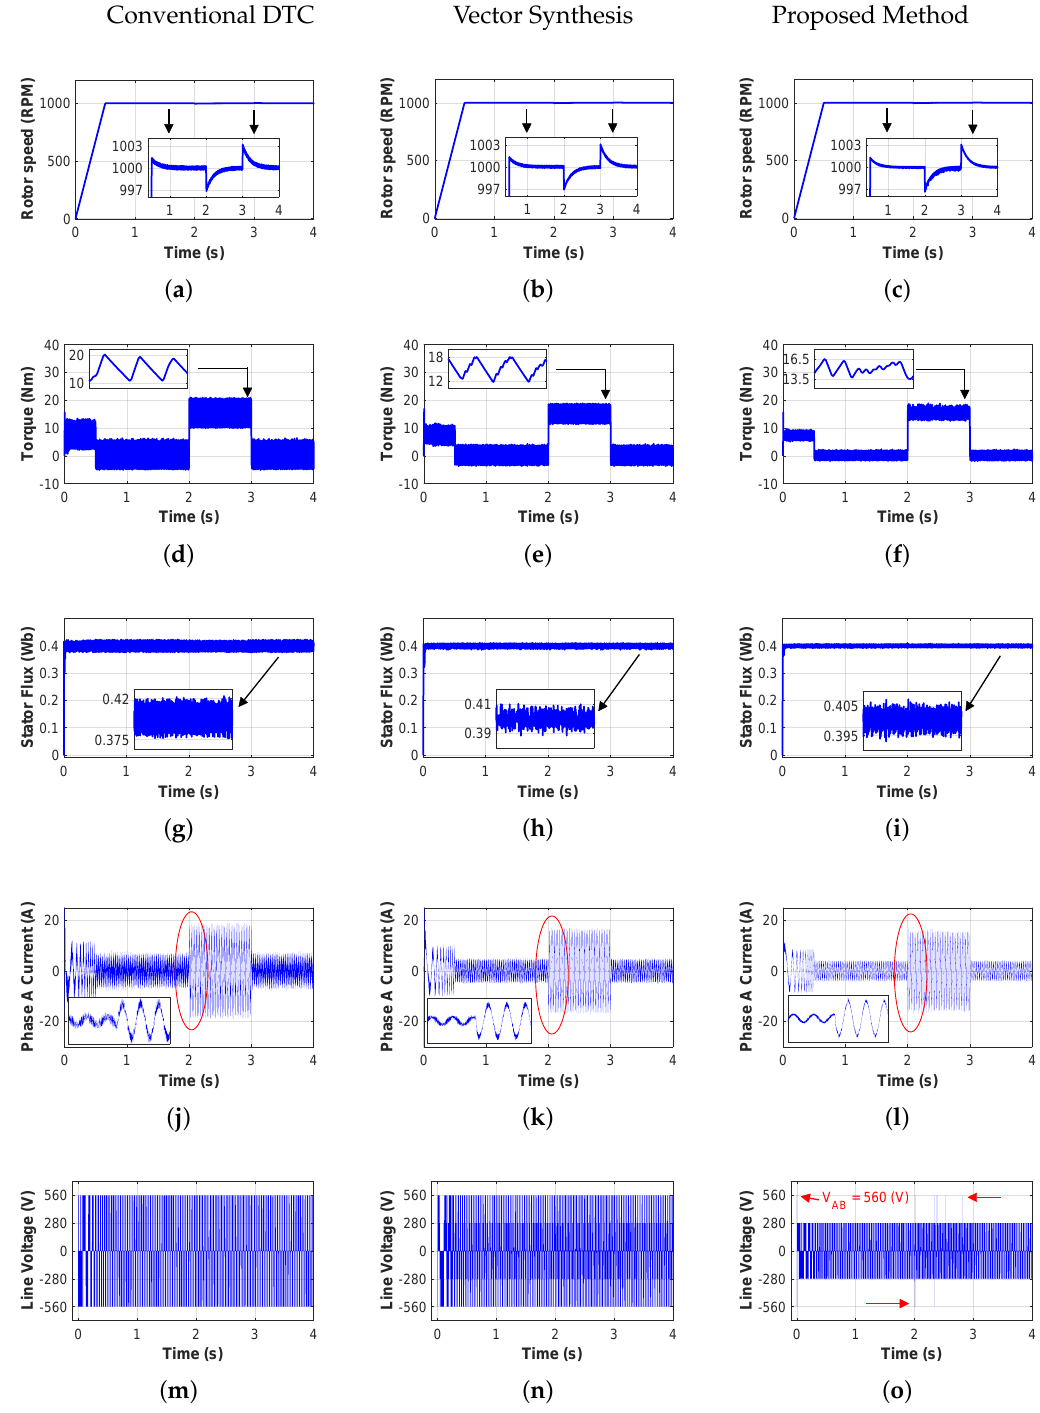
Figure 9. Simulation results for 1000 rpm under 15 N · m load torque disturbance: ( a – c ) rotor speed response; ( d – f ) motor torque; ( g – i ) stator flux; ( j – l ) input current; ( m – o ) line